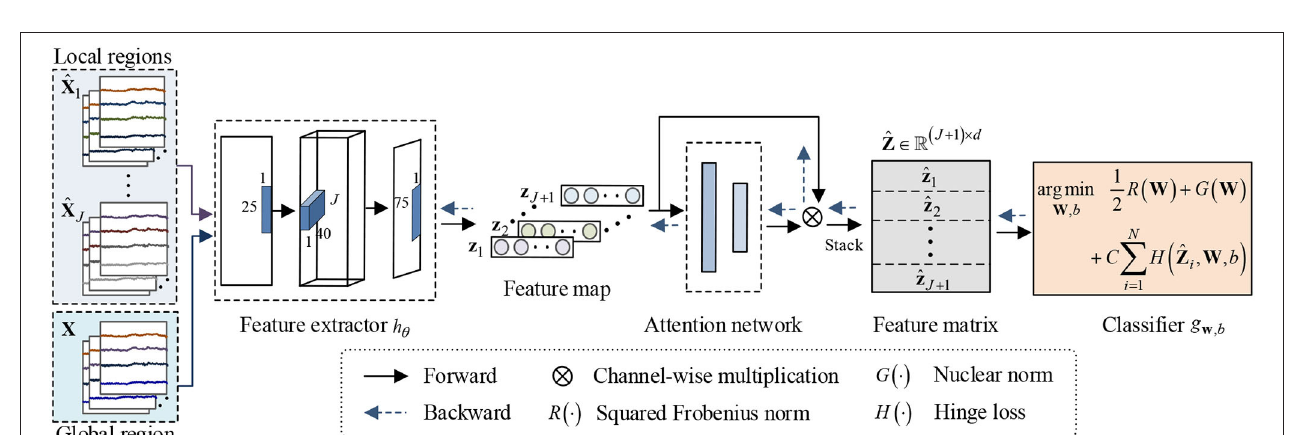
available affective EEG dataset. Experimental results demonstrate that our NRDNN outperforms other comparison